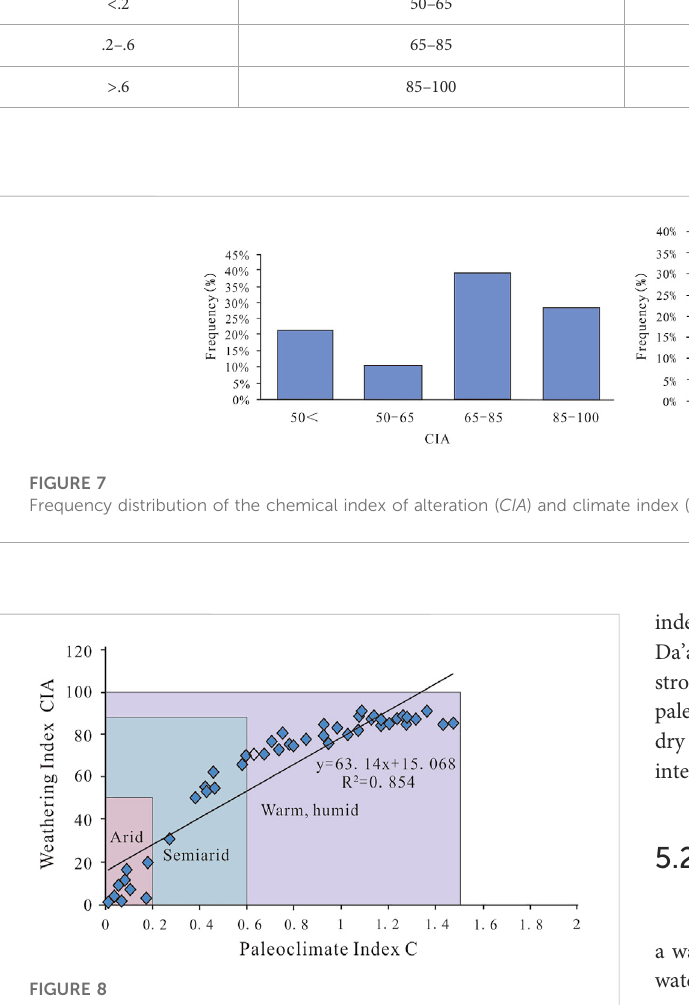
Distribution of climate Index ( C ) and chemical index of alteration ( CIA ) in the Da ’ anzhai Member of the Central Sichuan